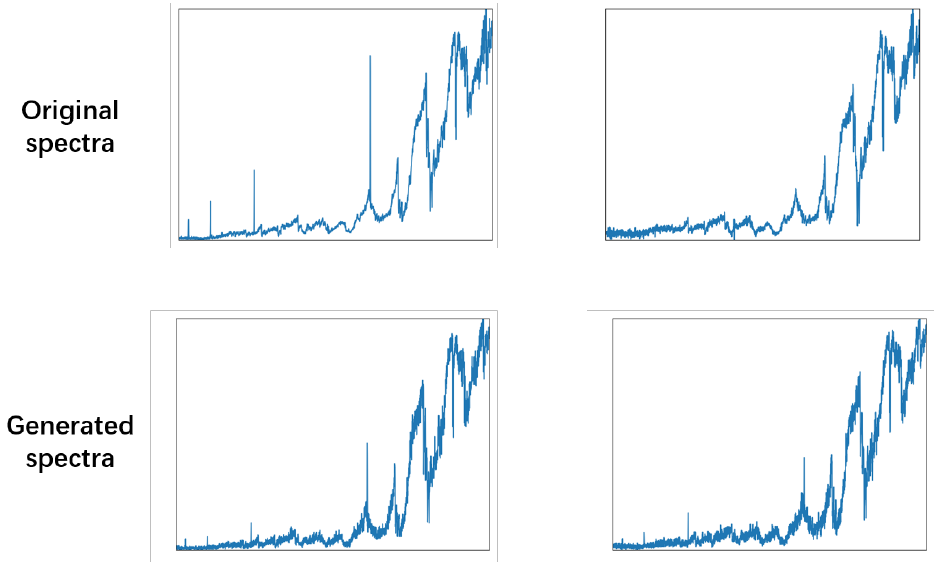
Figure 5. Compare original spectral data with generated spectral data.